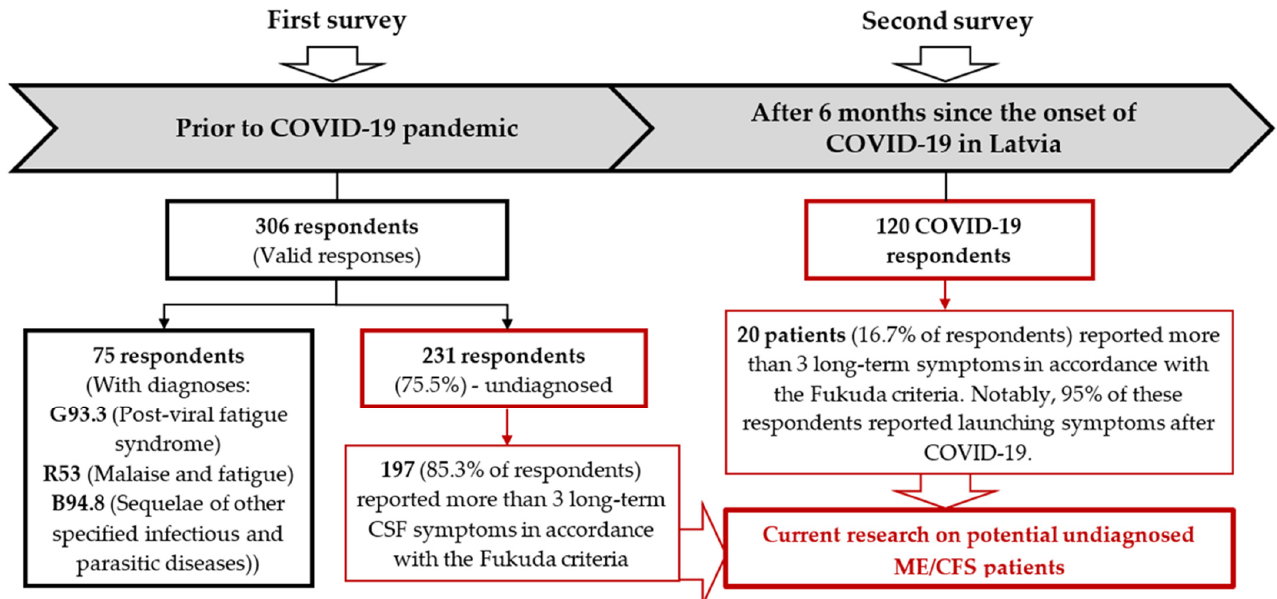
Figure 4. The empirical study design and outcomes.